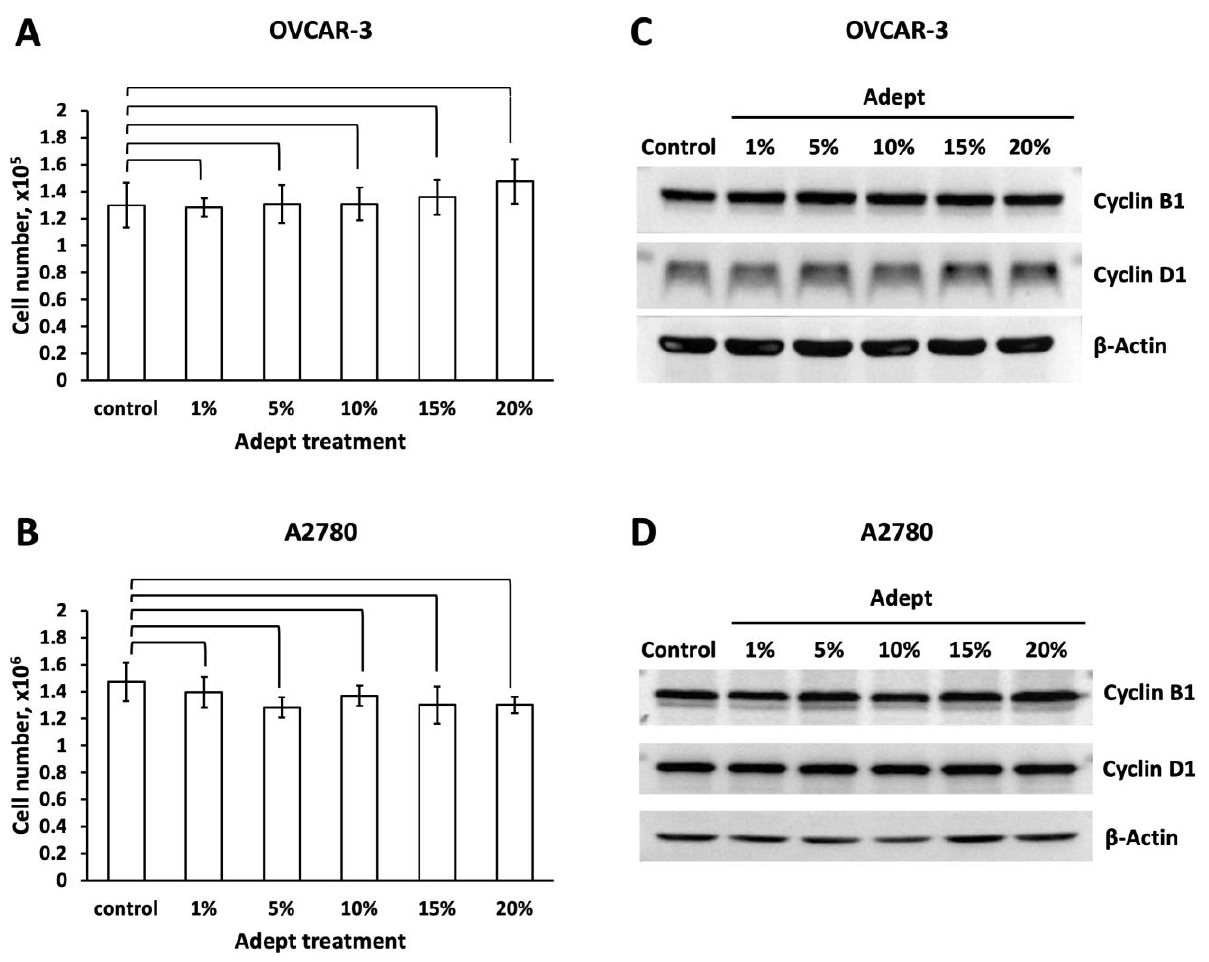
Figure 1. Various concentrations of Adept ® solution do not affect OVCAR-3 and A2780 cell growth and proliferation. ( A ) OVCAR-3 and ( B ) A2780 cells were plated in six-well plates at 1.1 × 10 4 cells/cm 2 and 5.6 × 10 3 cells/cm 2 , respectively, in regular medium for 3 days, then incubated in 1, 5, 10, 15 or 20% Adept ® (equal to 0, 0.04, 0.2, 0.4, 0.6 and 0.8% icodextrin) solution for 3 days; control cells were cultured in medium alone. After treatment for 3 days, cells were trypsinized and total live cell numbers were counted. The ratio of cell growth was calculated by normalizing the numbers of treated cells to the number of control cells ( n = 3 × 2). Total cell lysates from ( C ) OVCAR-3 and ( D ) A2780 cells treated with various concentrations of Adept ® solution were subjected to Western blot analysis to quantify the cell cycle regulation proteins cyclin B1 and cyclin D1; β -actin was used as a loading control.